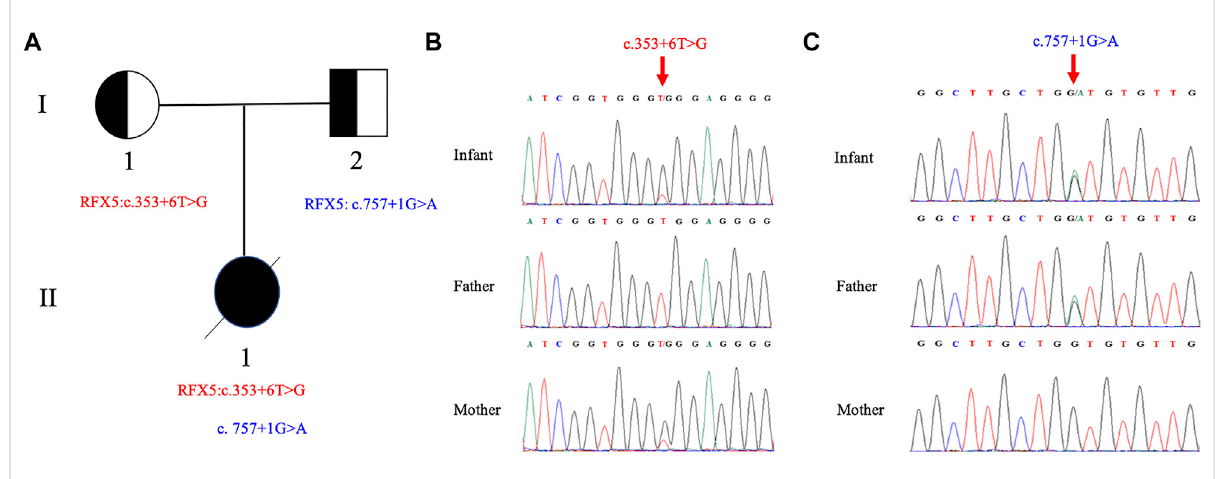
FIGURE 1 Pedigree of the family and Sanger sequence analysis. (A) II 1 (proband) have two compound splicing variants in RFX5 gene. One variant (c.353+6T > G) is from I 1 (mother) and the other (c.757+1G > A) is from I 2 (father). Chromatograms of (B) c.353+6T > G and (C) c.757+1G > A are identi fi ed by Sanger sequencing, respectively. The top chromatograms are from the infant, the middle two are from the father, and the bottom two are from the mother (red arrows indicate the